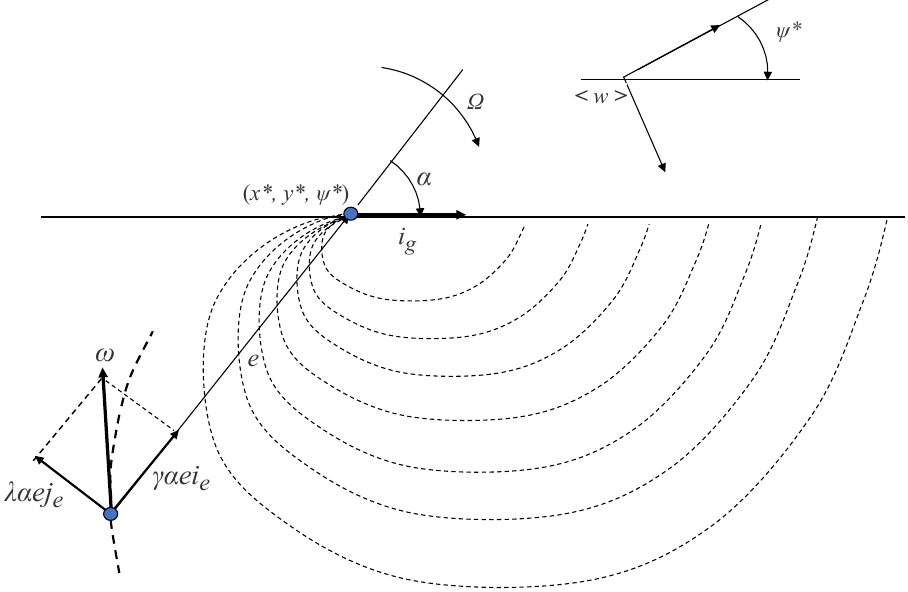
Figure 4. Velocity field-based approach in 2D planar